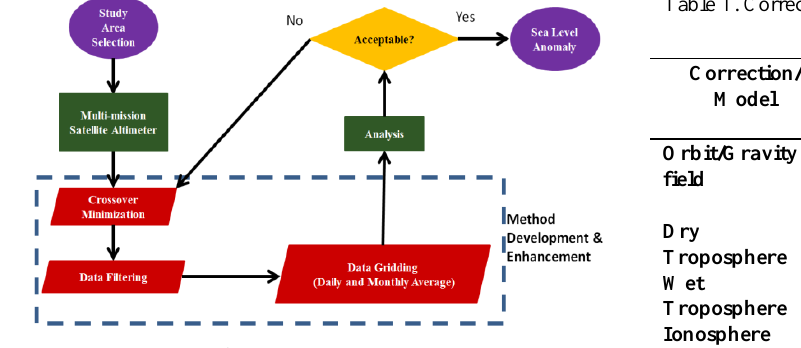
Figure 5. Overview of altimetry data processing Flow in RADS The sea level data are corrected for orbital altitude; altimeter range corrected for instrument, sea state bias, ionospheric delay, dry and wet tropospheric corrections, solid earth and ocean tides, ocean tide loading, pole tide electromagnetic bias and inverse barometer corrections. The bias is reduced by applying specific models for each satellite altimeter mission in RADS as shown in Table 1. After applying altimeter corrections and removing bias in RADS processing, the next step is to perform crossover adjustments.